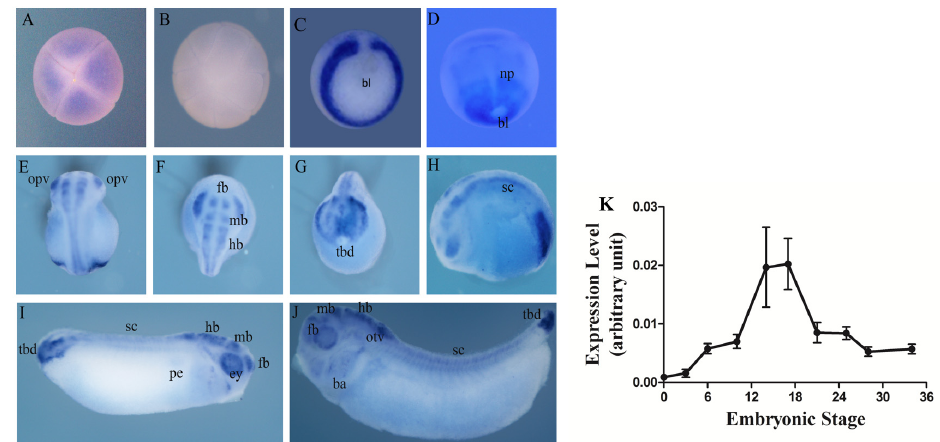
Figure 3. Spatiotemporal expression pattern of Hes5.9 during embryonic development of Xenopus tropicalis . The spatial expression pattern of Hes5.9 mRNA during development, which was examined by whole-mount in situ hybridization (WISH). ( A ) Cleavage stage 3, animal view; ( B ) Blastula stage 7, ventral view; ( C ) Early gastrula stage 10.5, vegetal view, dorsal to the top; ( D ) Early neurula stage 13, dorsal view, anterior to the top; ( E – G ) Mid neurula stage 19, dorsal view, anterior to the top in ( E ); anterior view, dorsal to the bottom in ( F ); posterior view, dorsal to the top in ( G ); ( H ) Late neurula stage 21, lateral view, dorsal to the top; ( I ) Early tailbud stage 28, lateral view, anterior to the right; ( J ) Late tailbud stage 35, lateral view, anterior to the left. ( K ) The temporal expression pattern of mRNA for Hes5.9 during X. tropicalis embryonic development examined by RT-qPCR, and ornithine decarboxylase ( Odc ) was applied as a constant expression control. Abbreviations, bl: